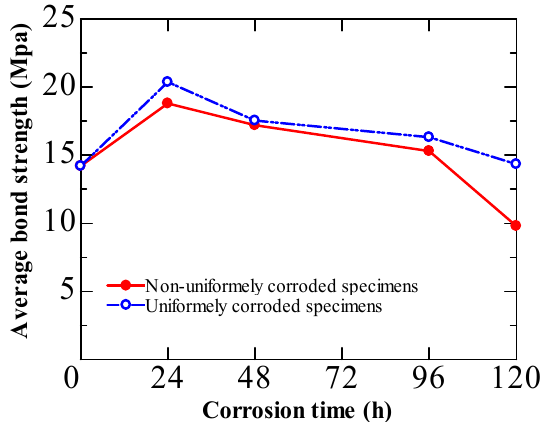
Figure 20. Influence of corrosion type on bond strength [87].